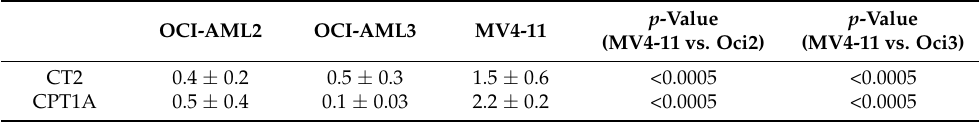
Values represent the mean ± SD. Statistical significances were evaluated through Student’s t